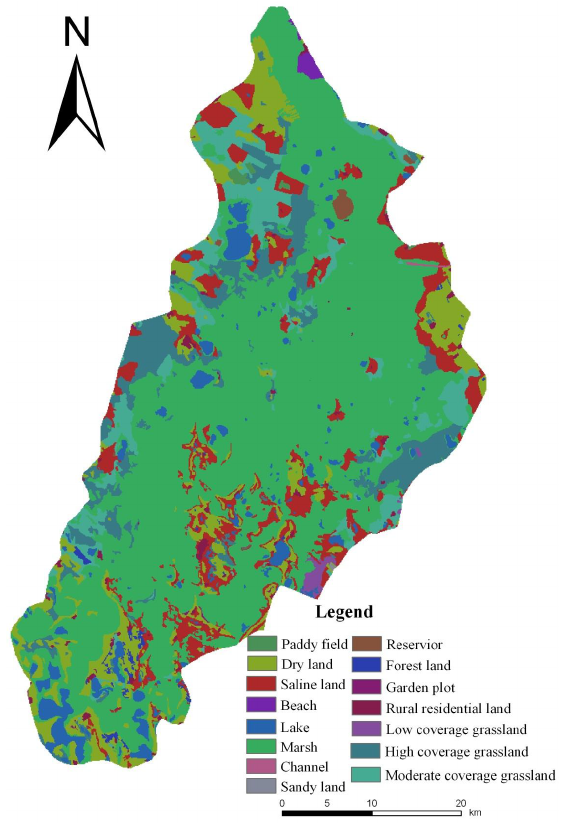
Fig. 3. Spatial distribution of land use types in the Zhalong wetland, Northeast China, in 2006.